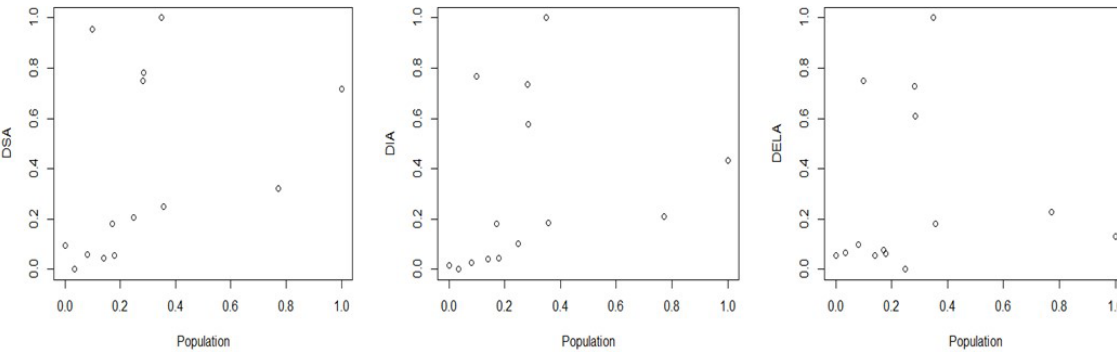
Figure 9. Scatterplots demonstrating the association between population and drought impact in Liaoning